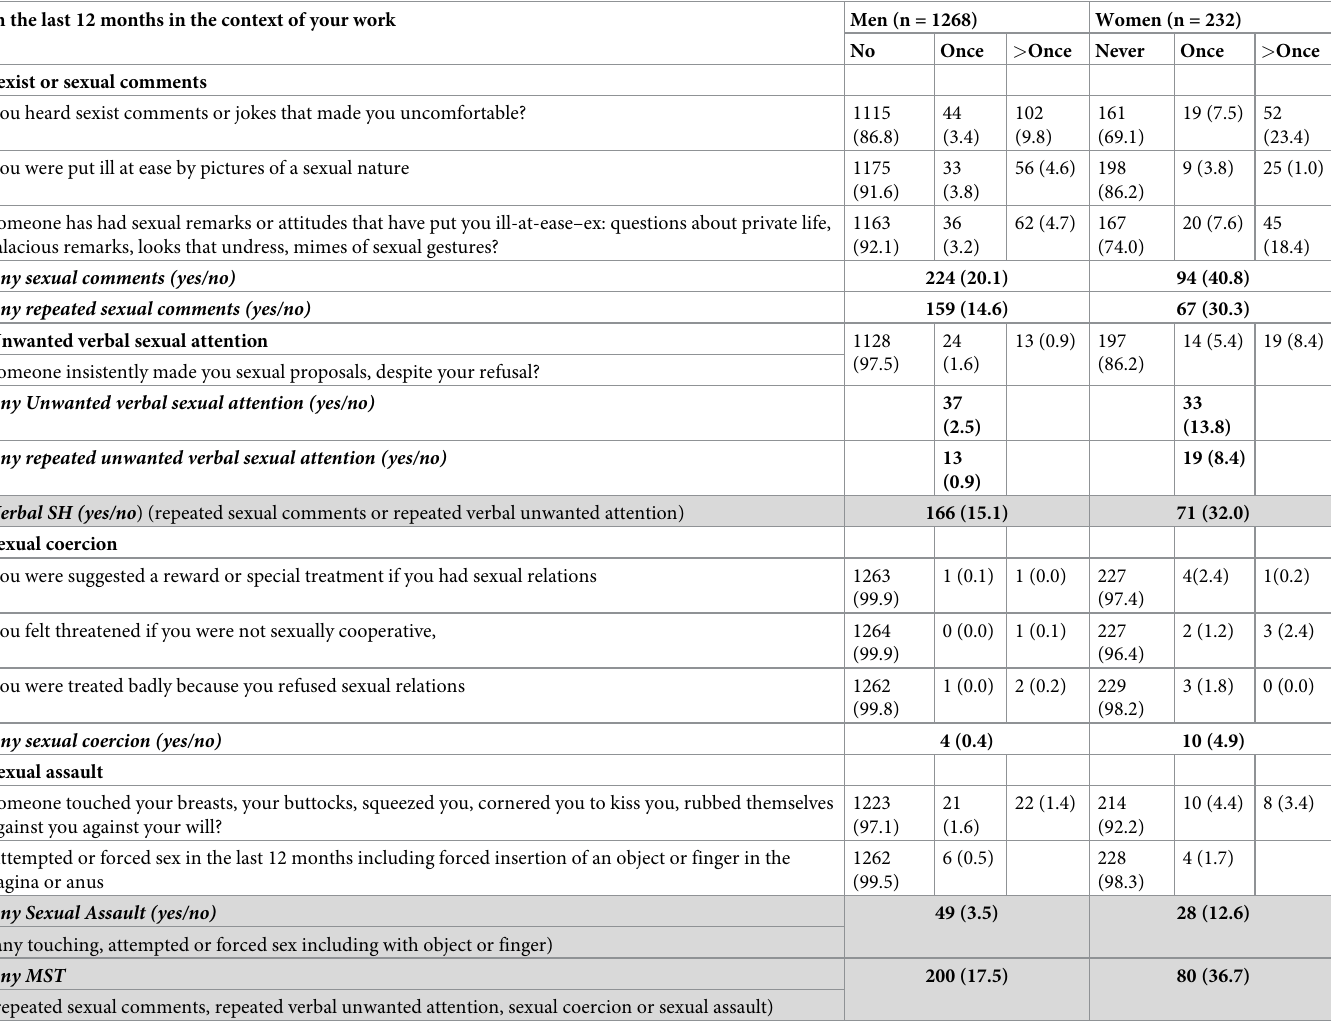
Table 2. Measures and prevalence of Sexual harassment , receipt of sexual comments , sexual coercion , unwanted sexual attention and assault in the military work environment in the last 12 months by gender, n (%). In the last 12 months in the context of your